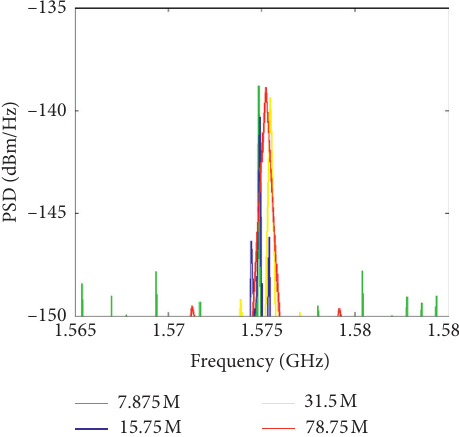
Figure 6: Power spectral density of UWB signal.